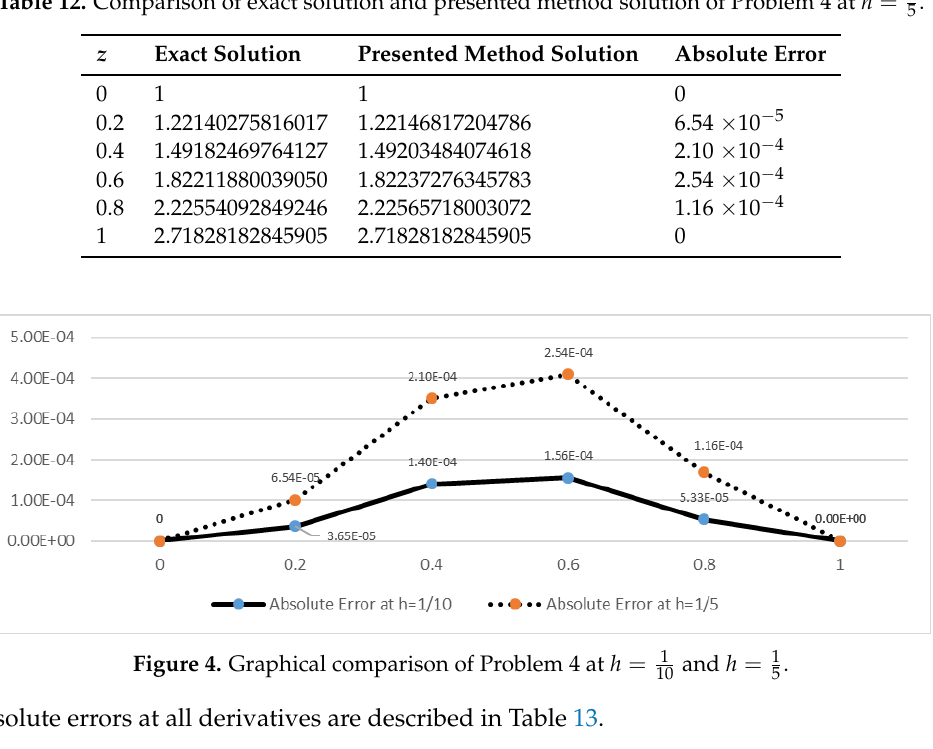
Table 12. Comparison of exact solution and presented method solution of Problem 4 at h = 1